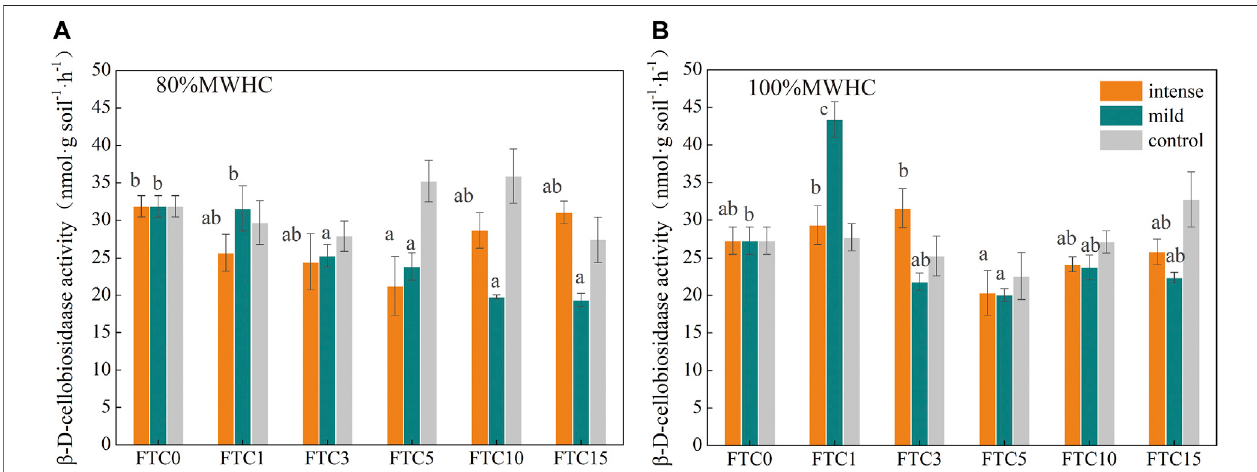
FIGURE 6 | β -D-cellobiosidase activity changes during the freeze – thaw cycles. (A) the β -D-cellobiosidase activity of 80%MWHC peat; (B) the β -D-cellobiosidase activity of 100%MWHC peat; mild means freeze – thaw cycle at − 5~4 ° C; intense means freeze – thaw cycle at − 15~4 ° C.